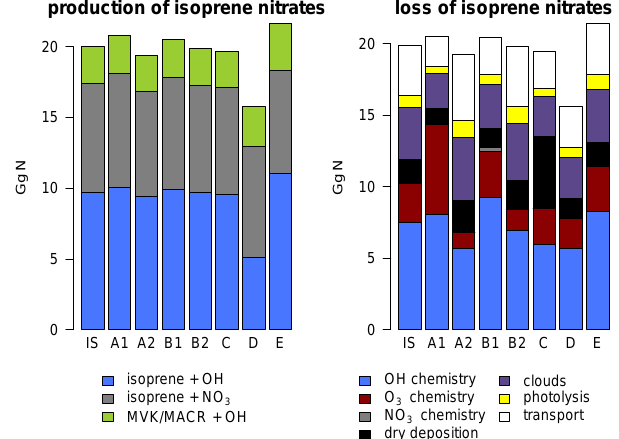
Fig. 6. Simulated production and loss processes for isoprene ni- trates from the IS simulation and its sensitivity cases (listed in Ta- ble 2). Results are summarized over the entire modeling period for the southeastern US within 2km of the